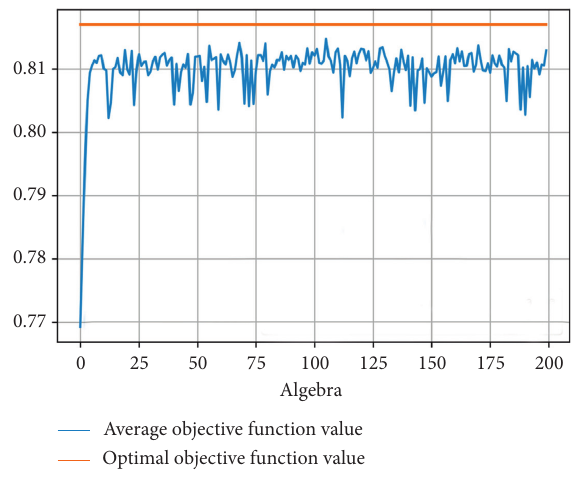
Figure 10: Standard genetic algorithm optimization